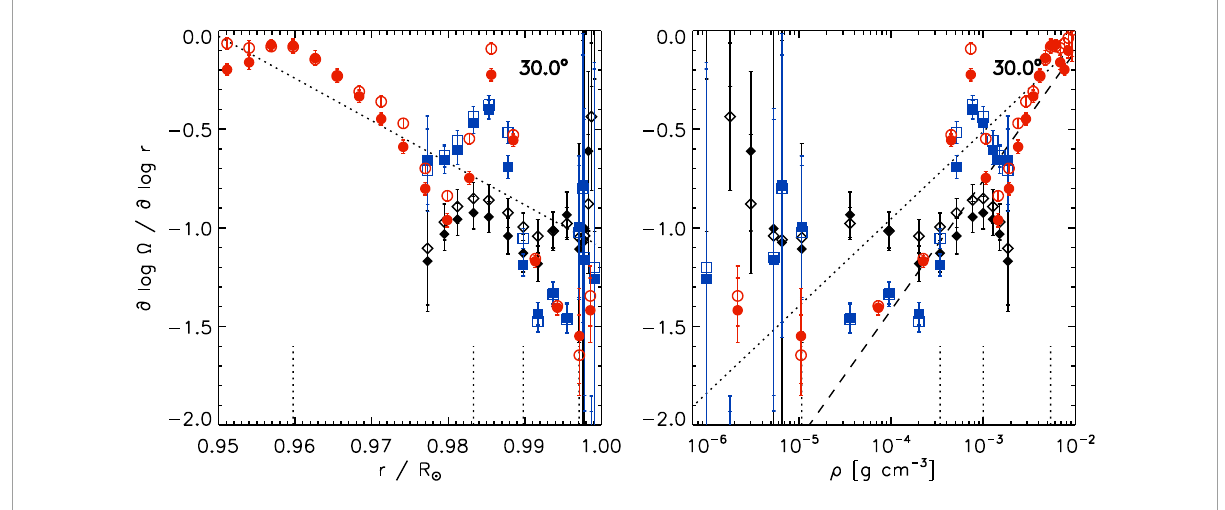
FIGURE 2 The radial gradient of the solar rotation rate as a function of radius (left) and density (right) using 15°-tile RDA (black diamonds: GONG, blue squares: HMI) and 30°-tile RDA (red circles: HMI) at 30° latitude for both hemispheres (filled symbols: southern, open symbols: northern hemisphere) averaged over Solar Cycle 24. The dotted and dashed lines are the same as in Figure 1 . The short vertical dotted lines indicate four depths (.960 R ⊙ , .983 R ⊙ , .990 R ⊙ , and .997 R ⊙ ). Compare with Figure 1 .